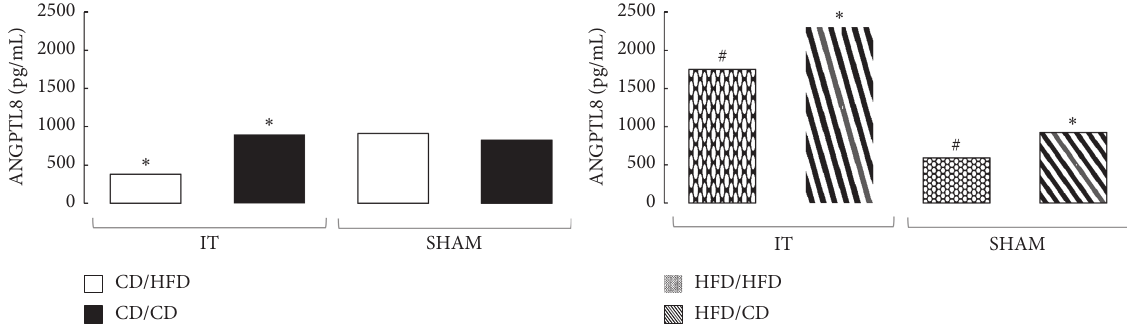
Figure 2: Median of ANGPTL8 plasma concentration in four diet groups according to operation type. Abbreviations: IT—ileal trans- position, SHAM—sham operated animals, CD—control diet, and HFD—high-fat diet. Preoperative diet/postoperative diet: CD/HFD, CD/ CD, HFD/HFD, HFD/CD (group size: n � 6, except IT HFD/HFD: n � 5). Sign ∗ or # denotes significant difference between median values; Kruskal–Wallis test, p < 0 . 05. Quartile deviation (Q25 and Q75) available in Supplementary